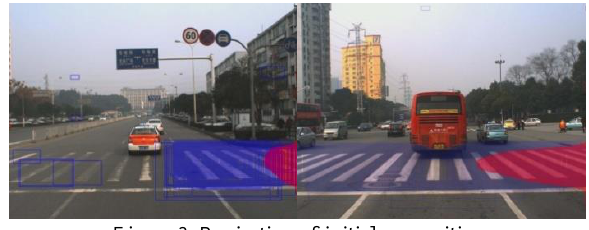
Figure 3. Projection of initial recognition